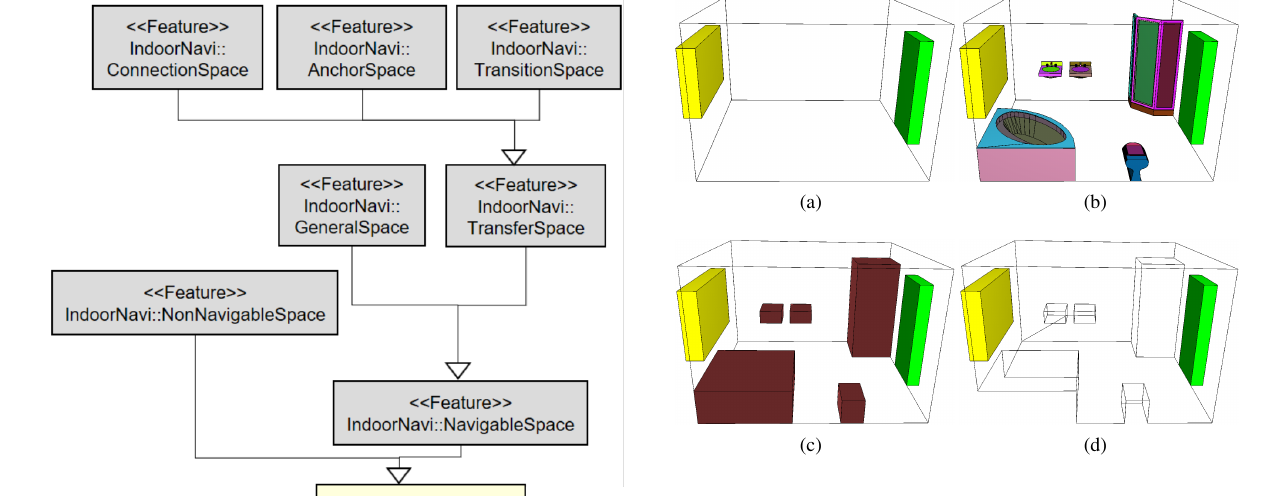
Figure 3. Difference in the indoor space when considering the furnishing elements. (a) An empty bathroom represented by different volumes: the room layout (wire-frame), a window (yellow) and a door (green). (b) The furnishing objects. (c) Figure 1. Classes involved in the classification of the space cells Identification of the space occupied by the furnishing elements (Kang and Li, 2017). (dark red). (d) Actual free space in the